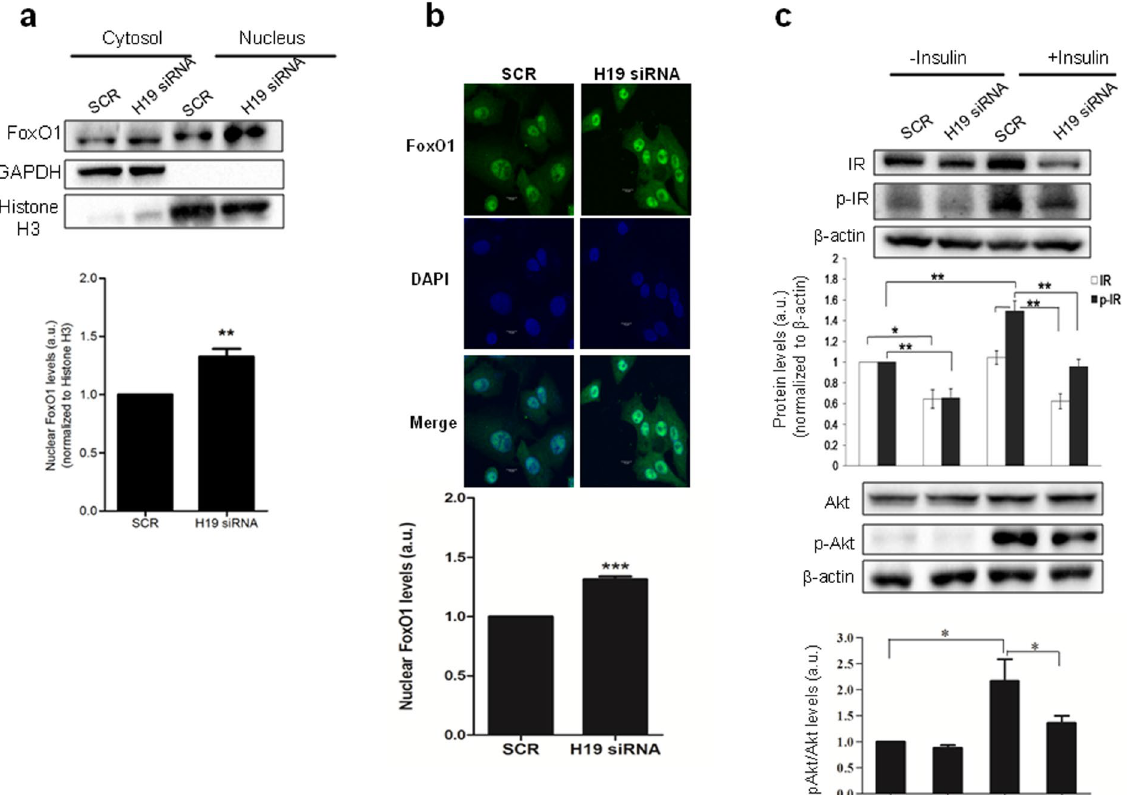
Figure 6. H19 inhibition increases nuclear localization of FoxO1 and impairs insulin signalling. ( a ) HepG2 cells were reverse transfected either with H19 siRNA (5 nM) or with the scramble (SCR), and after 48 h of incubation nuclear and cytoplasmic protein fractions were isolated as described in the “Methods” section. 30 µ g protein from cytoplasmic and nuclear fraction was subjected to Western blot analysis using anti-FoxO1 antibody. GAPDH and Histone H3 were used as normalization controls for cytoplasmic and nuclear fractions, respectively. A representative blot is shown. Densitometric analysis of FoxO1 levels in the nuclear fractions of scramble and H19 siRNA transfected cells is also shown. Full length blots are presented in Supplementary Information (Supplementary Fig. S3). ( b ) HepG2 cells were plated on cover slips and reverse transfected either with H19 siRNA (5 nM) or the scramble (SCR) as described in “a”. After 48 h, cells were fixed and stained as described in the methods section with anti-FoxO1 antibody followed by Alexa Fluor-488 conjugated goat anti- rabbit IgG. Nuclei were counterstained with DAPI. Cells were visualized and levels of FoxO1 were quantified. Scale bar 10 µ m. A representative figure is shown on the top and given below is the quantification of the nuclear levels of FoxO1. ( c ) HepG2 cells were transfected as in “a” and then incubated in the absence or presence of insulin (100 nM, 20 min). Cells were lysed, and the levels of total IR, pIR, total Akt and pAkt were estimated by Western blot analyses. β -Actin was taken as the normalization control. Full length blots are presented in Supplementary Information (Supplementary Fig. S4). Each value is the mean of three such experiments. Values presented are mean ± SEM. * P < 0.05, ** P < 0.01, *** P < 0.001. a.u., arbitrary